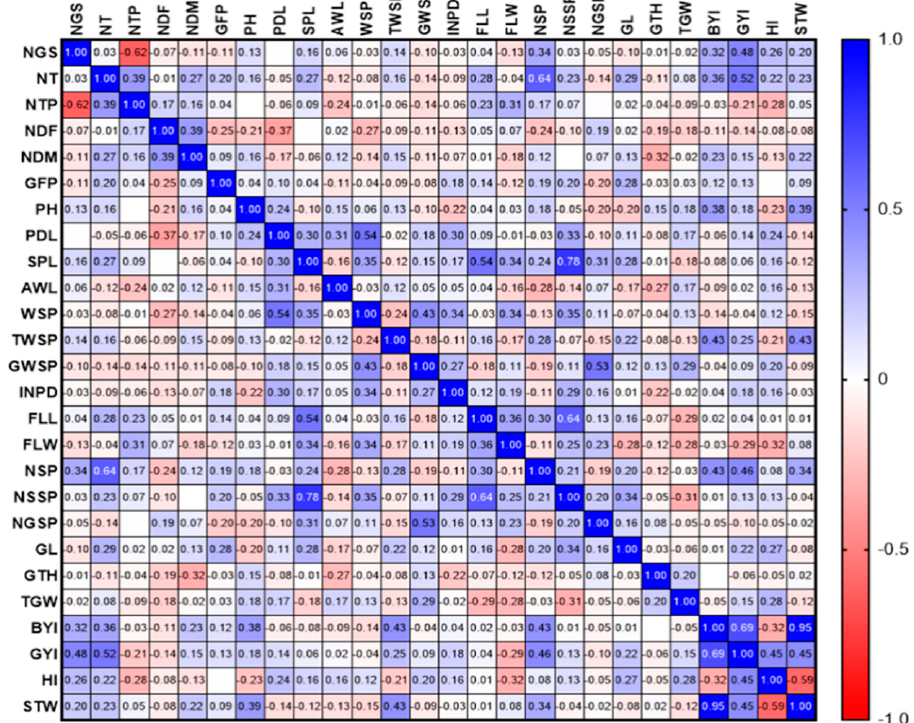
Figure 3. Correlation of study traits in F8 wheat lines resulting from Gonbad × Zagros in 2021.